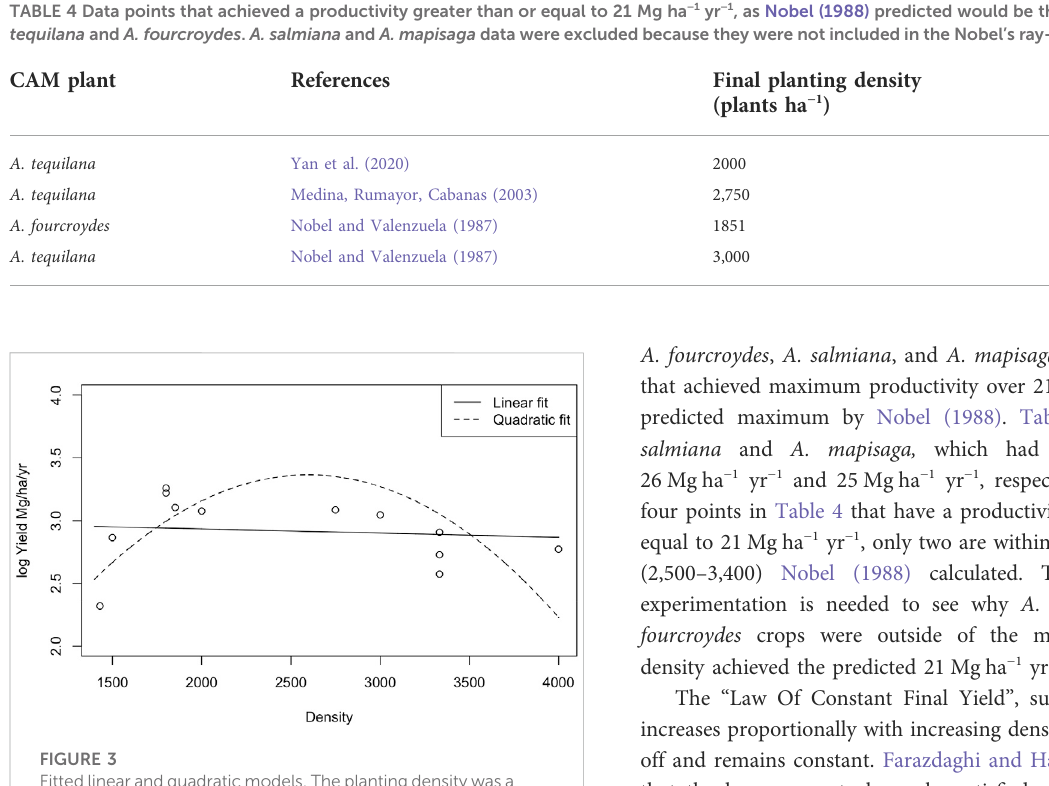
FIGURE 3 Fitted linearandquadraticmodels. Theplantingdensity wasa signi fi cant predictor of yield in the quadratic model (X 2 = 33.890, df = 2, p = 4.373 × 10 − 8 ).